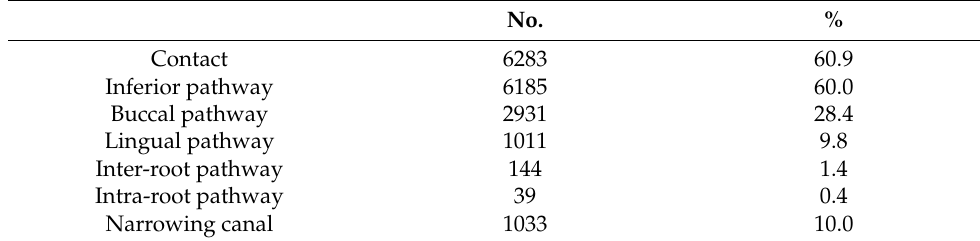
tomography (CBCT).